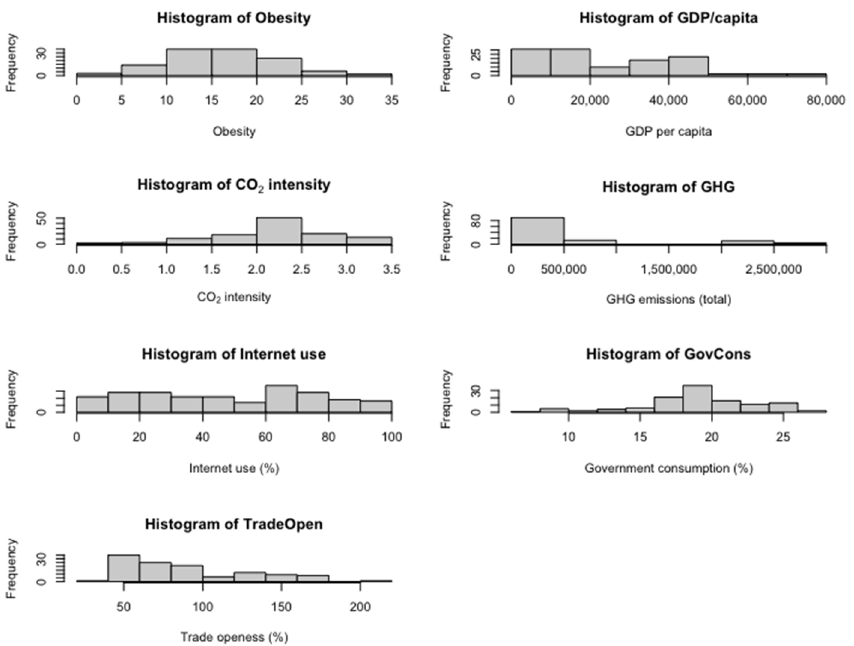
Figure 3. Histograms for the variables of interest. Table 3. Descriptive